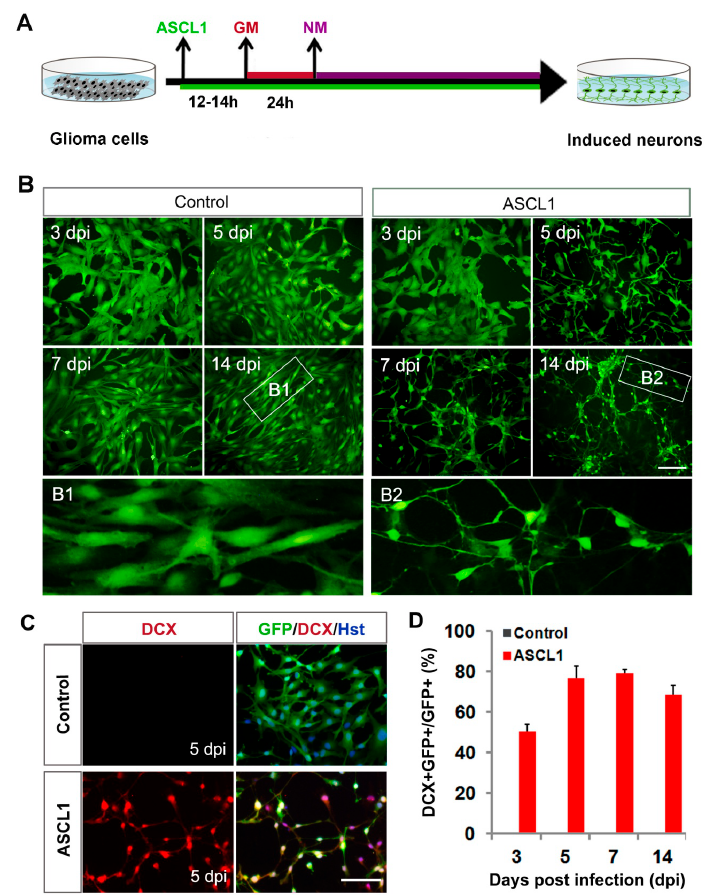
Figure 3. Fate change of human glioma cells induced by ASCL1. ( A ) Experimental schemes of ASCL1-mediated lineage reprogramming. GM, growth medium; NM, neuronal induction medium. ( B ) Ectopic expression of ASCL1 resulted in rapid morphological changes of U251 cells. GFP-expressing virus was used as a control. Higher magnification views of the boxed regions are also shown. ( C ) ASCL1-converted cells expressed immature neuronal marker DCX. ( D ) Quantitative analysis of induced DCX-positive cells. Scales: 100 μ m ( B and C ).